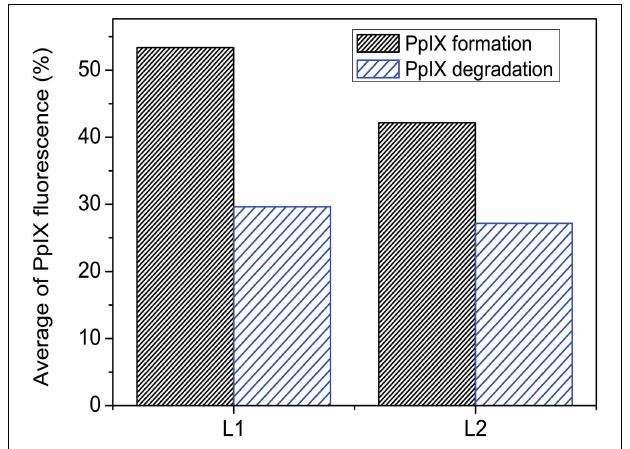
FIGURE 6 | Mean value of red pixels in fluorescence images of different lesions (L1 and L2), comparing the formation and degradation of PPIX in different anatomical sites in the same patient.